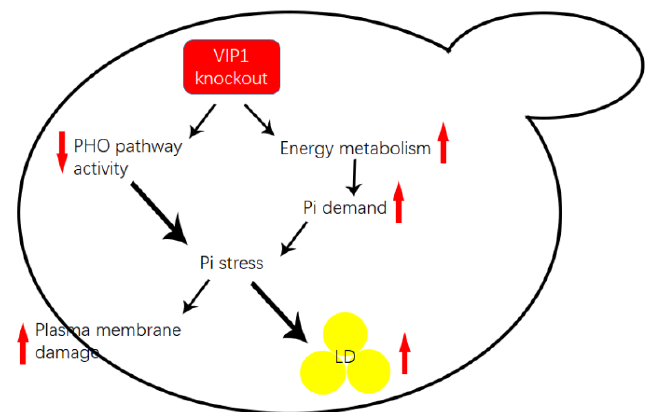
Figure 5. Proposed mechanisms of Pi stress in the C. albicans vip1 Δ/Δ strain.